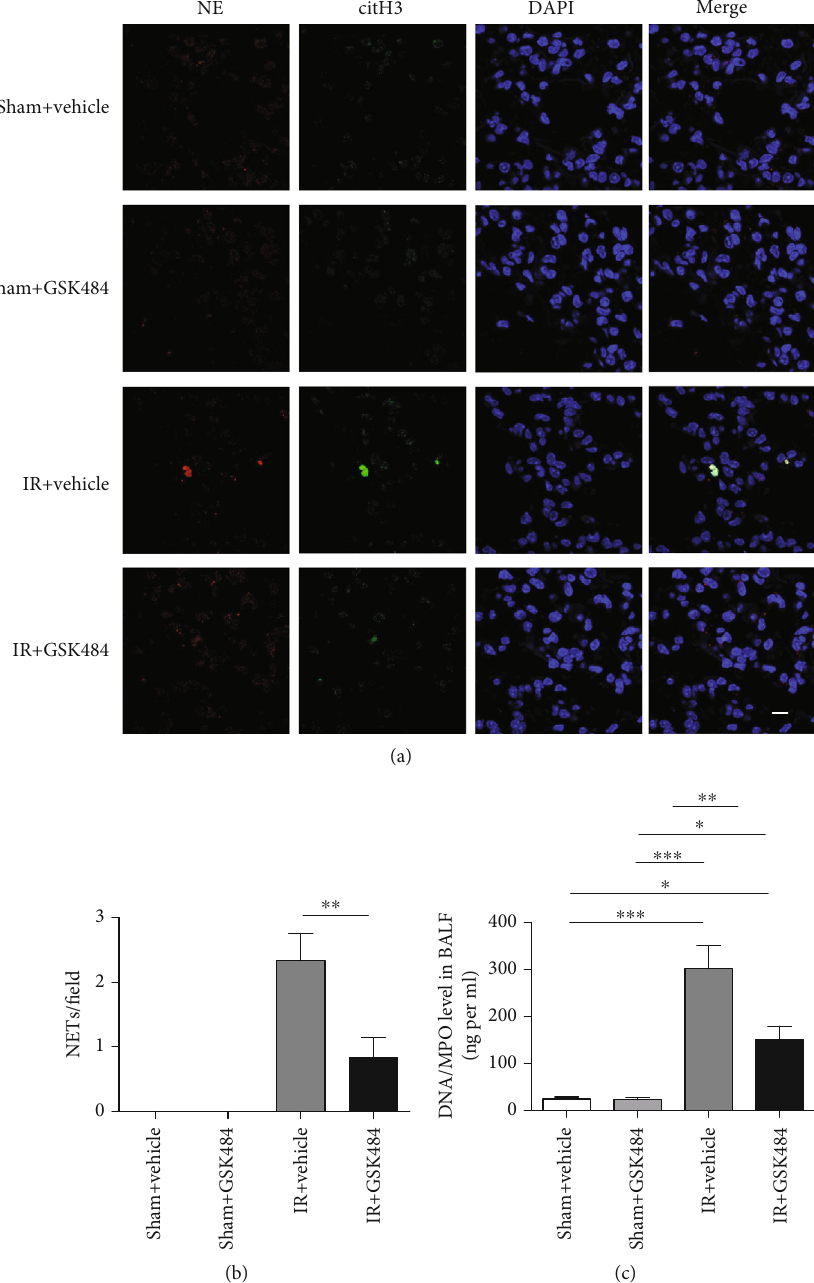
Figure 4: Neutrophil extracellular traps (NETs) in the mouse lung following renal IR-induced pulmonary injury. (a) Representative confocal images of NETs demonstrated colocalization of NE and CitH3 with di ff use DAPI staining nuclei. NETs: neutrophil extracellular traps; CitH3: citrullinated histone H3 (scale bar: 10 μ m). (b) Quanti fi cation of NETs in pulmonary sections from di ff erent groups. (c) Quanti fi cation of DNA/MPO levels in bronchoalveolar lavage fl uid (BALF). The data are the means ± SEMs ; n = 6 ; ∗ p < 0 : 05 , ∗∗ p < 0 : 01 , and ∗∗∗ p < 0 : 001